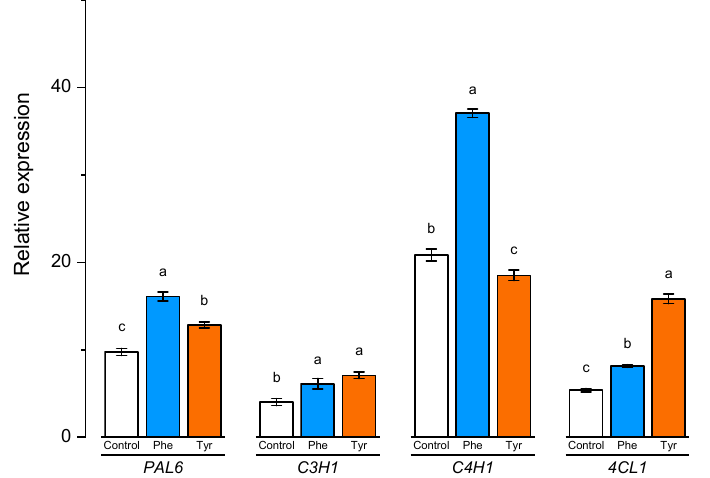
Figure 8. Relative quantification values of PAL6 , C4H1 , 4CL1, and C3H1 in wheat leaves affected by the phenylalanine and tyrosine levels in the nutrient medium. Bars marked with different letters show significant differences at ( p ≤ 0.05) according to Tukey’s test.